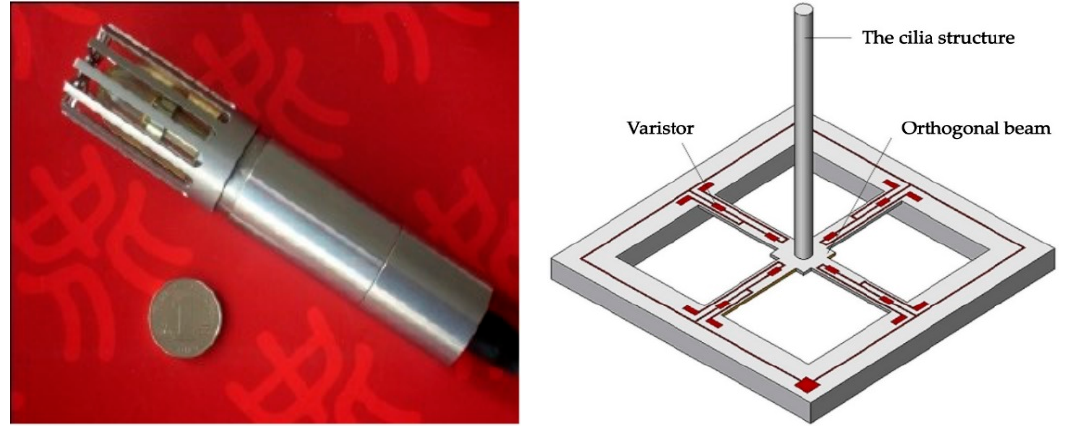
Figure 10. The basic structure of the hydrophone.